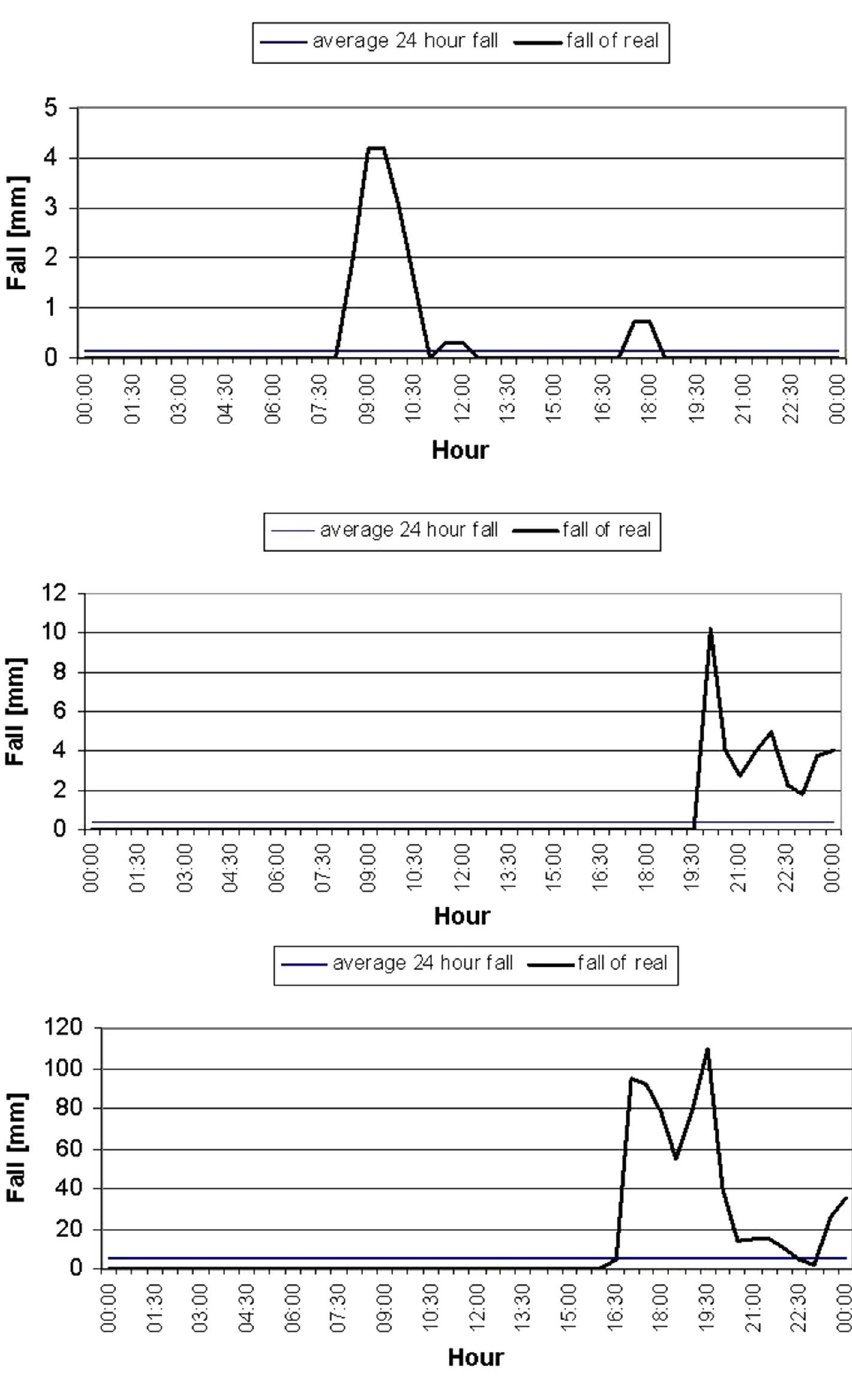
Fig. 6 Falls in day 18.02.,